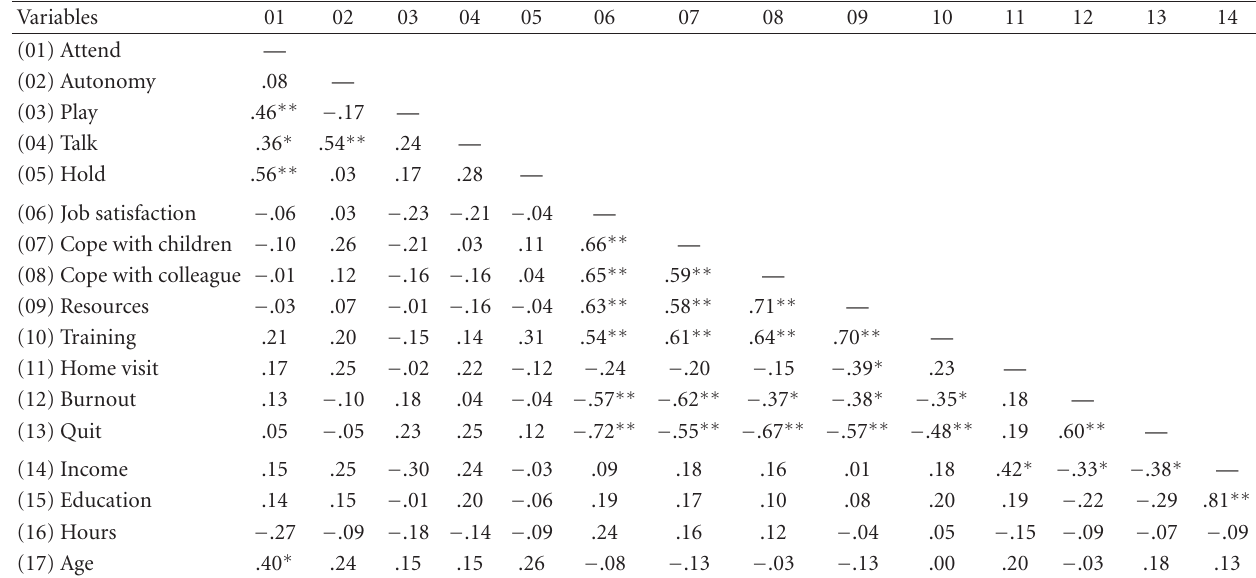
Table 1: Pearson correlation coe ffi cients among caregiving involvement, job conditions, and SES variables.